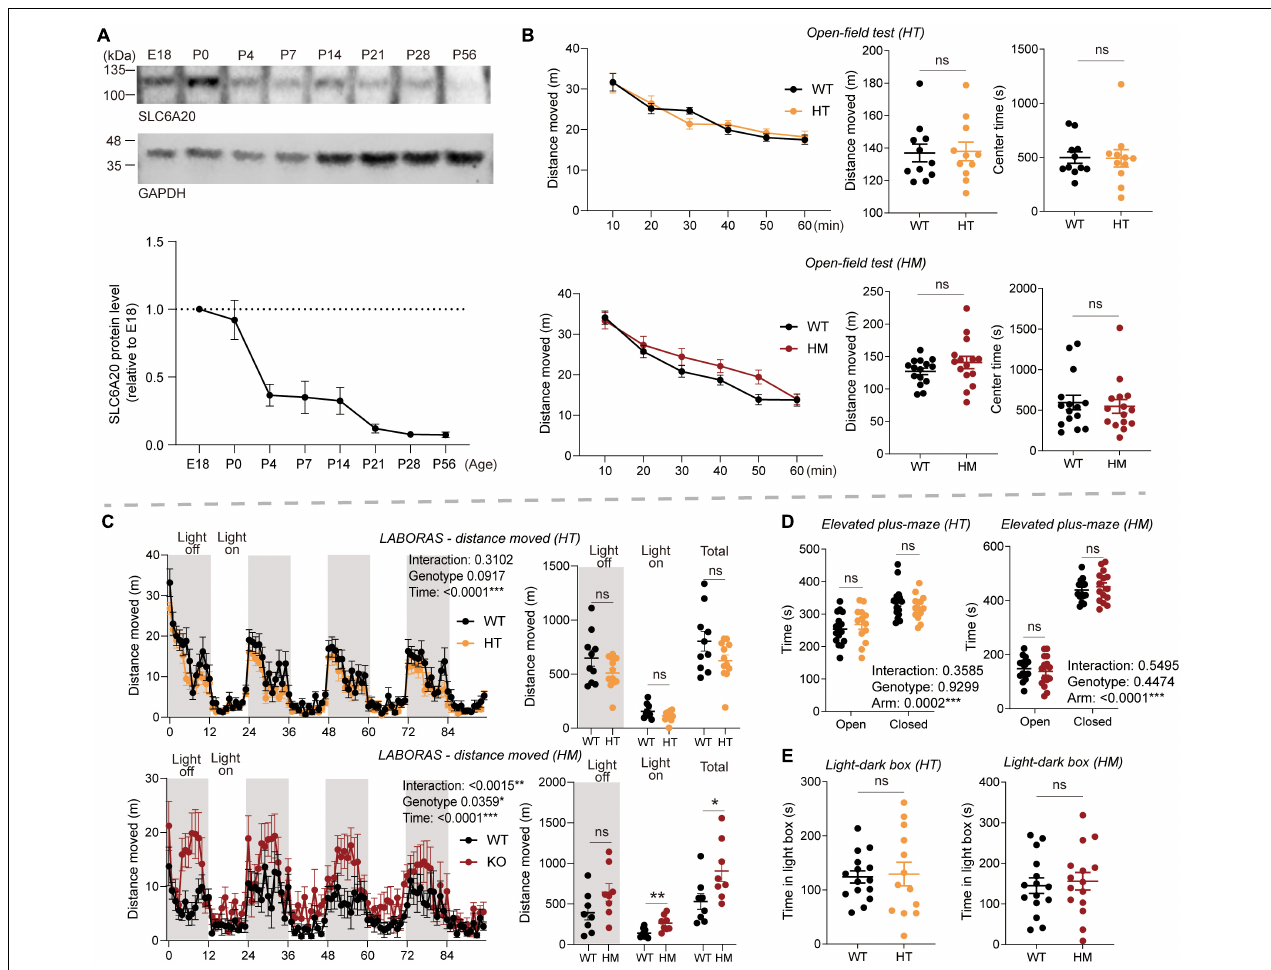
FIGURE 1 | Slc6a20a deficiency in mice induces moderate hyperactivity without affecting anxiety-like behavior. (A) Temporal expression pattern of SLC6A20A proteins in mouse brains at the indicated embryonic (E) and postnatal (P) days. Whole-brain lysates were immunoblotting with SLC6A20 and control (GAPDH) antibodies. SLC6A20 signals were normalized to GAPDH signals for quantification. Note that the utilized pan-SLC6A20 antibody could recognize both SLC6A20A and SLC6A20B proteins in the brain; the expression level of SLC6A20A seems to be about three times greater based on the decrease in the pan-SLC6A20 signal of Slc6a20a homozygous mutant mouse brain (Bae et al., 2021) ( n = 4 mice). (B) Locomotor activity in the open-field test is normal in Slc6a20a + / − and Slc6a20a − / − mice (3–6 months; HT and HM, respectively) compared with WT mice, as shown by distance moved. Note that there is no genotype difference in the time spent in the center region of the open-field area, suggestive of normal anxiety-like behavior. ( n = 11 mice [WT for HT], 11 [HT], 15 [WT for HM], 15 [HM], two-way repeated-measures/RM-ANOVA [distance moved] and Student’s t -test [total distance moved, time in center]). (C) Locomotor activity is moderately increased in Slc6a20a − / − but not Slc6a20a + / − mice in the Laboras test, where mouse movements were measured for 4 consecutive days. Note that Slc6a20a − / − mice show hyperactivity during the total and light-on periods but not the light-off period, suggestive of disturbed sleep. ( n = 10 mice [WT for HT], 12 [HT], 8 [WT for HM], 8 [HM], two-way RM-ANOVA [distance moved across 4 days] and Student’s t -test [total distance moved during total, light-off, and light-on periods]). (D) Anxiety-like behavior is normal in Slc6a20a + / − and Slc6a20a − / − mice (3–6 months) in the elevated plus-maze test, as shown by time spent in the open/closed arms. ( n = 16 mice [WT for HT], 13 [HT], 15 [WT for HM], 15 [HM], Student’s t -test). (E) Anxiety-like behavior is normal in Slc6a20a + / − and Slc6a20a − / − mice (3–6 months) in the light-dark test, as shown by time in the light chamber. ( n = 15 mice [WT for HT], 13 [HT], 15 [WT for HM], 15 [HM], Student’s t -test). Statistical significance and p values in the graphs; * p < 0.05, ** p < 0.01, *** p < 0.001, ns, not